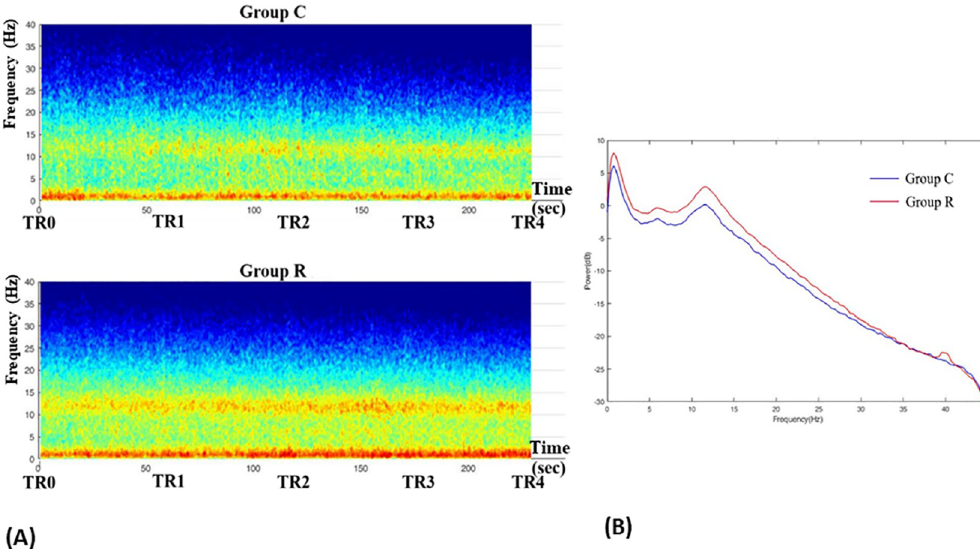
Fig 4. Group-median spectrogram (A) and power spectra (B) during TR0–TR4 comparing group C with group R. The group-median spectrograms (A) and power spectra (B) were plotted from the 4-min EEG data, and a distinct difference is evident. The power in the alpha, delta and slow-wave frequency bands was greater in group R than in group C.